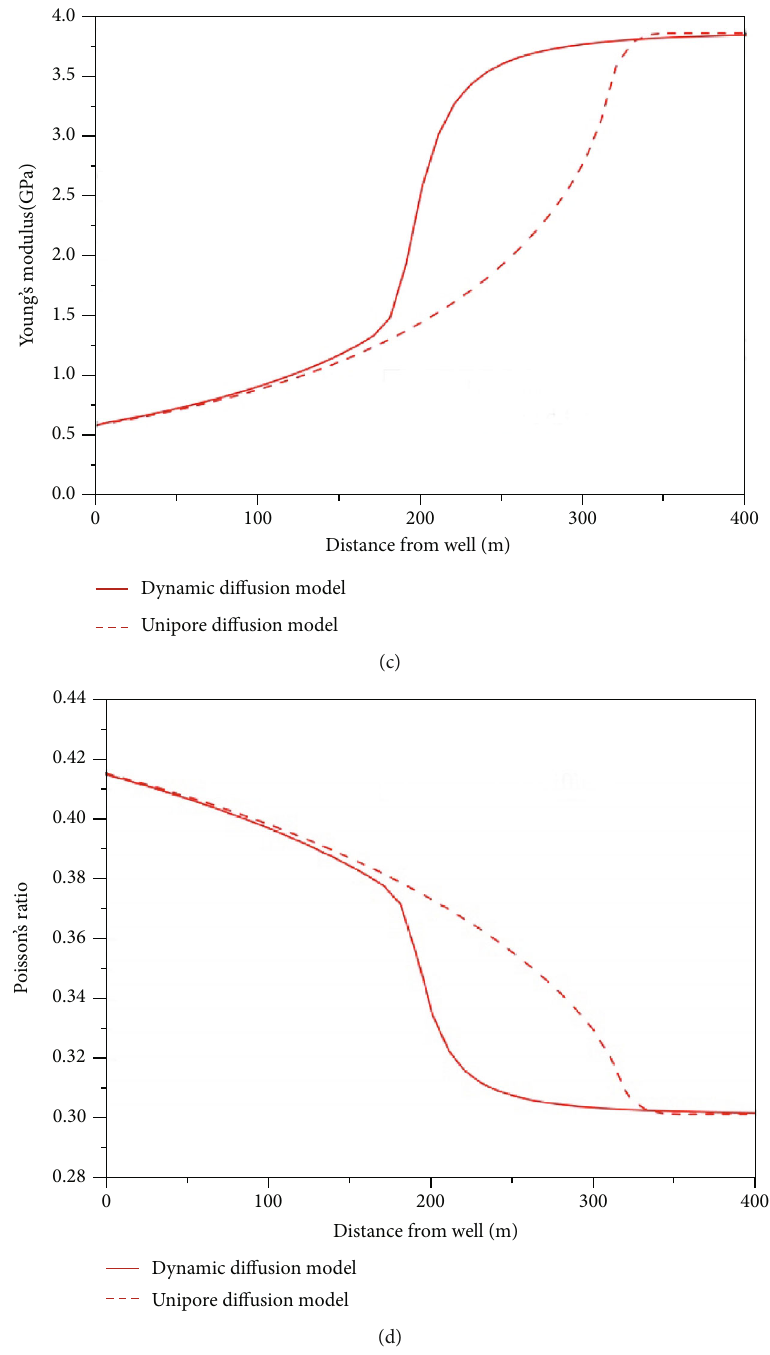
Figure 12: Impact of dynamic di ff usion on fl uid transfer and coal